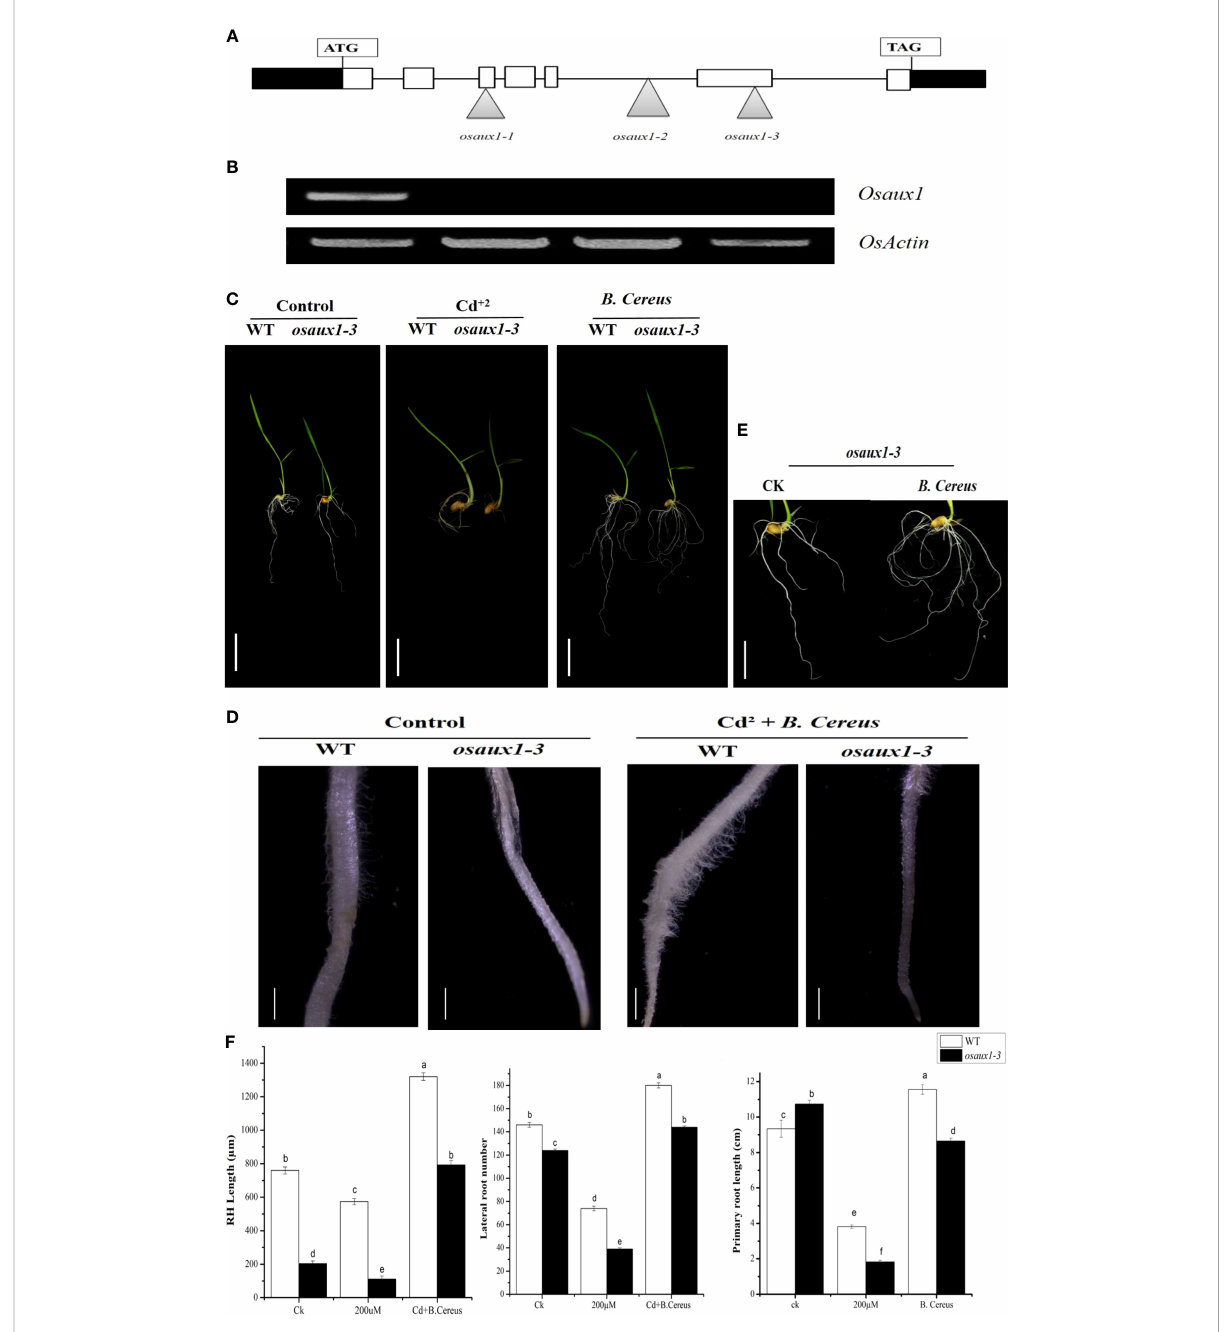
FIGURE 1 Three T-DNA insertion lines were identi fi ed in the OsAux1 gene. (A) Schematic representation of T-DNA insertion mutations in osaux1 -1, osaux1 -2, and osaux1 - 3 in the OsAux1 gene. The open arrow heads represent T-DNA insertion positions. Filled white boxes represent exons; black boxes represent untranslated region; black lines represent introns. (B) Detection of RT-PCR of OsAuxX1 transcripts in WT (Dongjin) osaux1-1 , osaux1-2 , and osaux1-3 ; actin transcripts were ampli fi ed as a control. (C) Seven-day phenotypic comparison of grown seedlings of wild-type (Dongjin), mutant lines osaux1-3 , and (B) cereus -inoculated under Cd treatment. Scale bar, 1 cm. (D) Root hair morphology of (B) cereus -inoculated and noninoculated wild-type and osaux1-3 after 3 days of treatment with 200 µM CdCl 2 using Nikon AZ100. Scale bar, 1 mm. (E) Focused image of osaux1-3 mutant under control. (F) Root phenotype quanti fi cation of PR length, LR root number, and RH length in wild- type and mutant lines grown in Cd bacterial-inoculated and noninoculated (controlled) conditions. Five seedlings from each of three replicates were assessed and grown for 10 days. Lowercase letters indicate signi fi cant differences between means, determined using Duncan ’ s multiple range mean